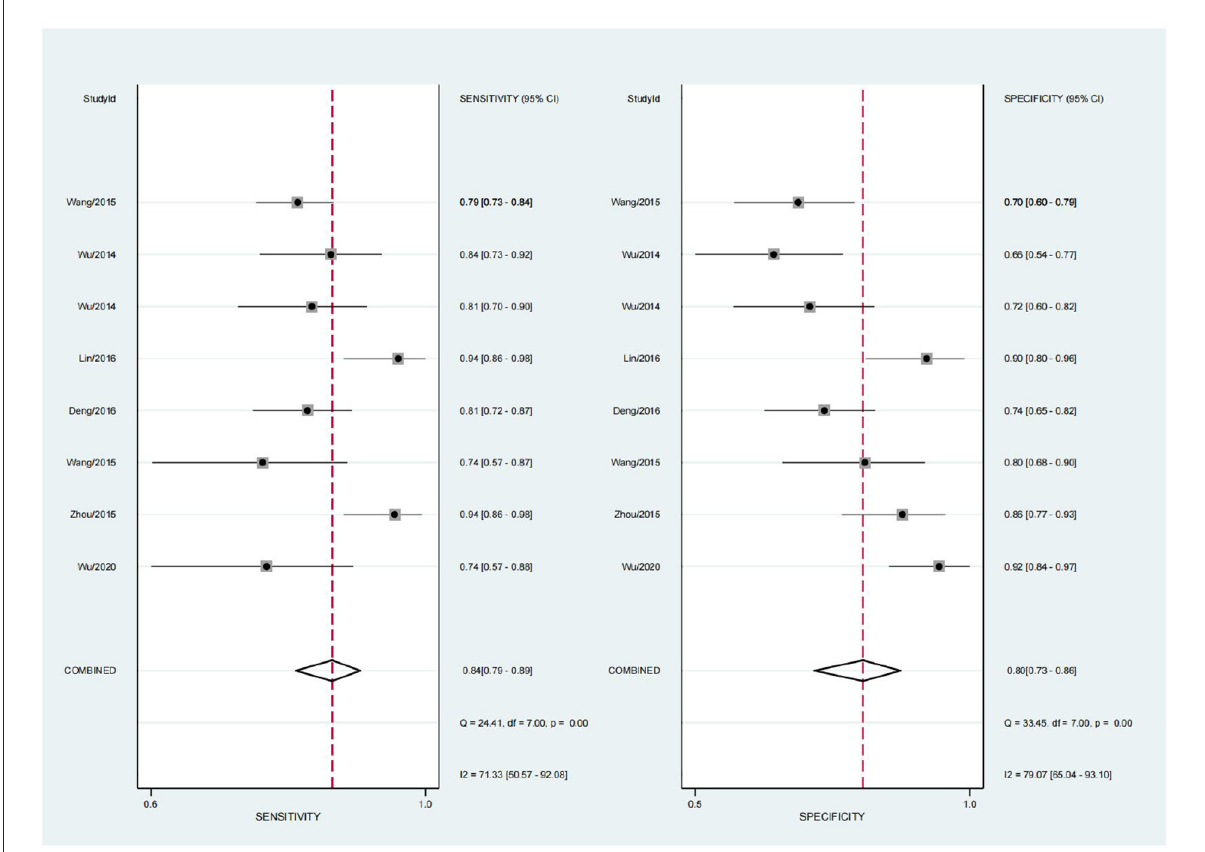
FIGURE3 Combined sensitivity and specificity of miRNA in the diagnosis of HTN with LVH.